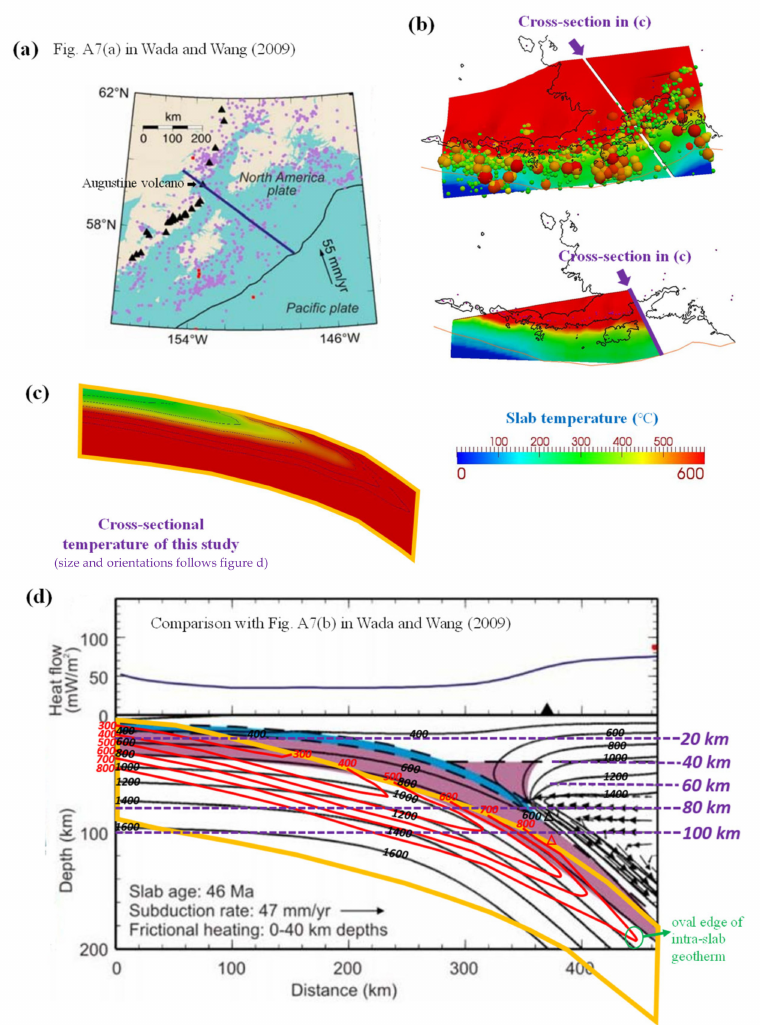
Figure 3. Comparison between our model result and Wada and Wang [23]. Black curves and symbols are from Wada and Wang [23], while yellow curves (slab surface) and red curves (intraslab thermal contours) are from this study. ( a ) The profile used to estimate the cross-section thermal structure in Alaska by 2-D model [23]. ( b ) Obtained the same profile from our 3-D model. ( c ) Cross-section thermal structure along the same profile in this study. ( d ) Slab geometry difference and modeled thermal result difference between Wada and Wang [23] and this